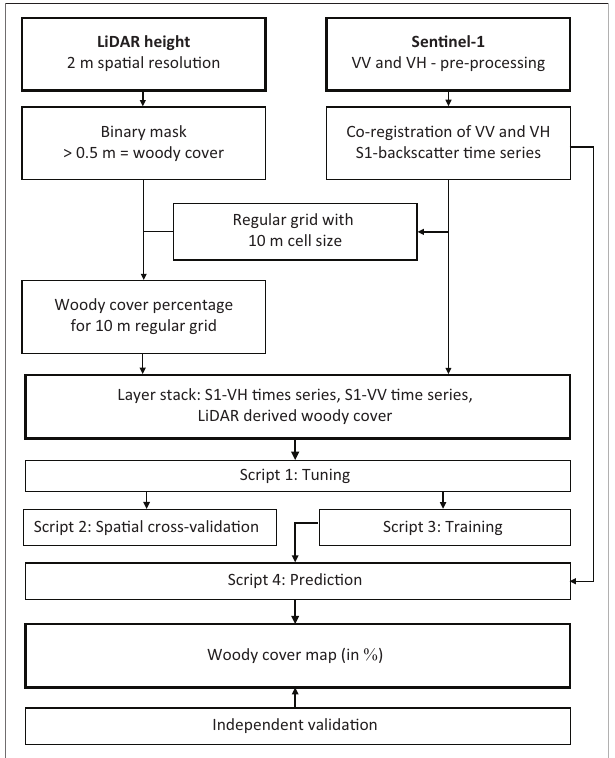
FIGURE 1: The methodological framework for deriving woody cover information from Sentinel-1 time series by using light detection and ranging information (Scripts 1–4 are freely available via zenodo.org